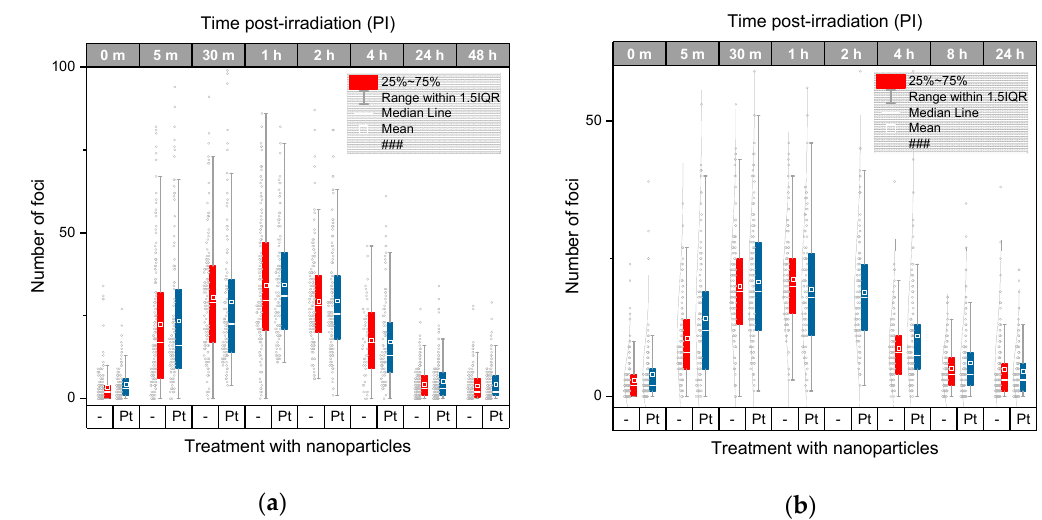
Figure 3. Manual analysis of the extent of γ H2AX+53BP1 focus (DSB) induction and repair kinetics in U87 glioblastoma cells irradiated with 4 Gy of γ -rays compared with cells treated (0.5 mM for 6 h) and not treated prior to irradiation with 2.6 nm platinum nanoparticles (Pt-NPs). The average and median numbers of co-localized γ H2AX + 53BP1 repair foci (i.e., DSBs) per nucleus are shown for different periods of time PI, together with the focus number distributions in each cell population. The boxes include 50% of the values (25th to 75th percentile) centered on the median (the horizontal line through the box). The mean values are represented by the squares within the boxes. The outliers were identified according to the 1.5 * IQR method (IQR = interquartile range). Pt—samples treated with platinum nanoparticles, m—the period of time after irradiation in minutes, 0 m—non-irradiated samples.